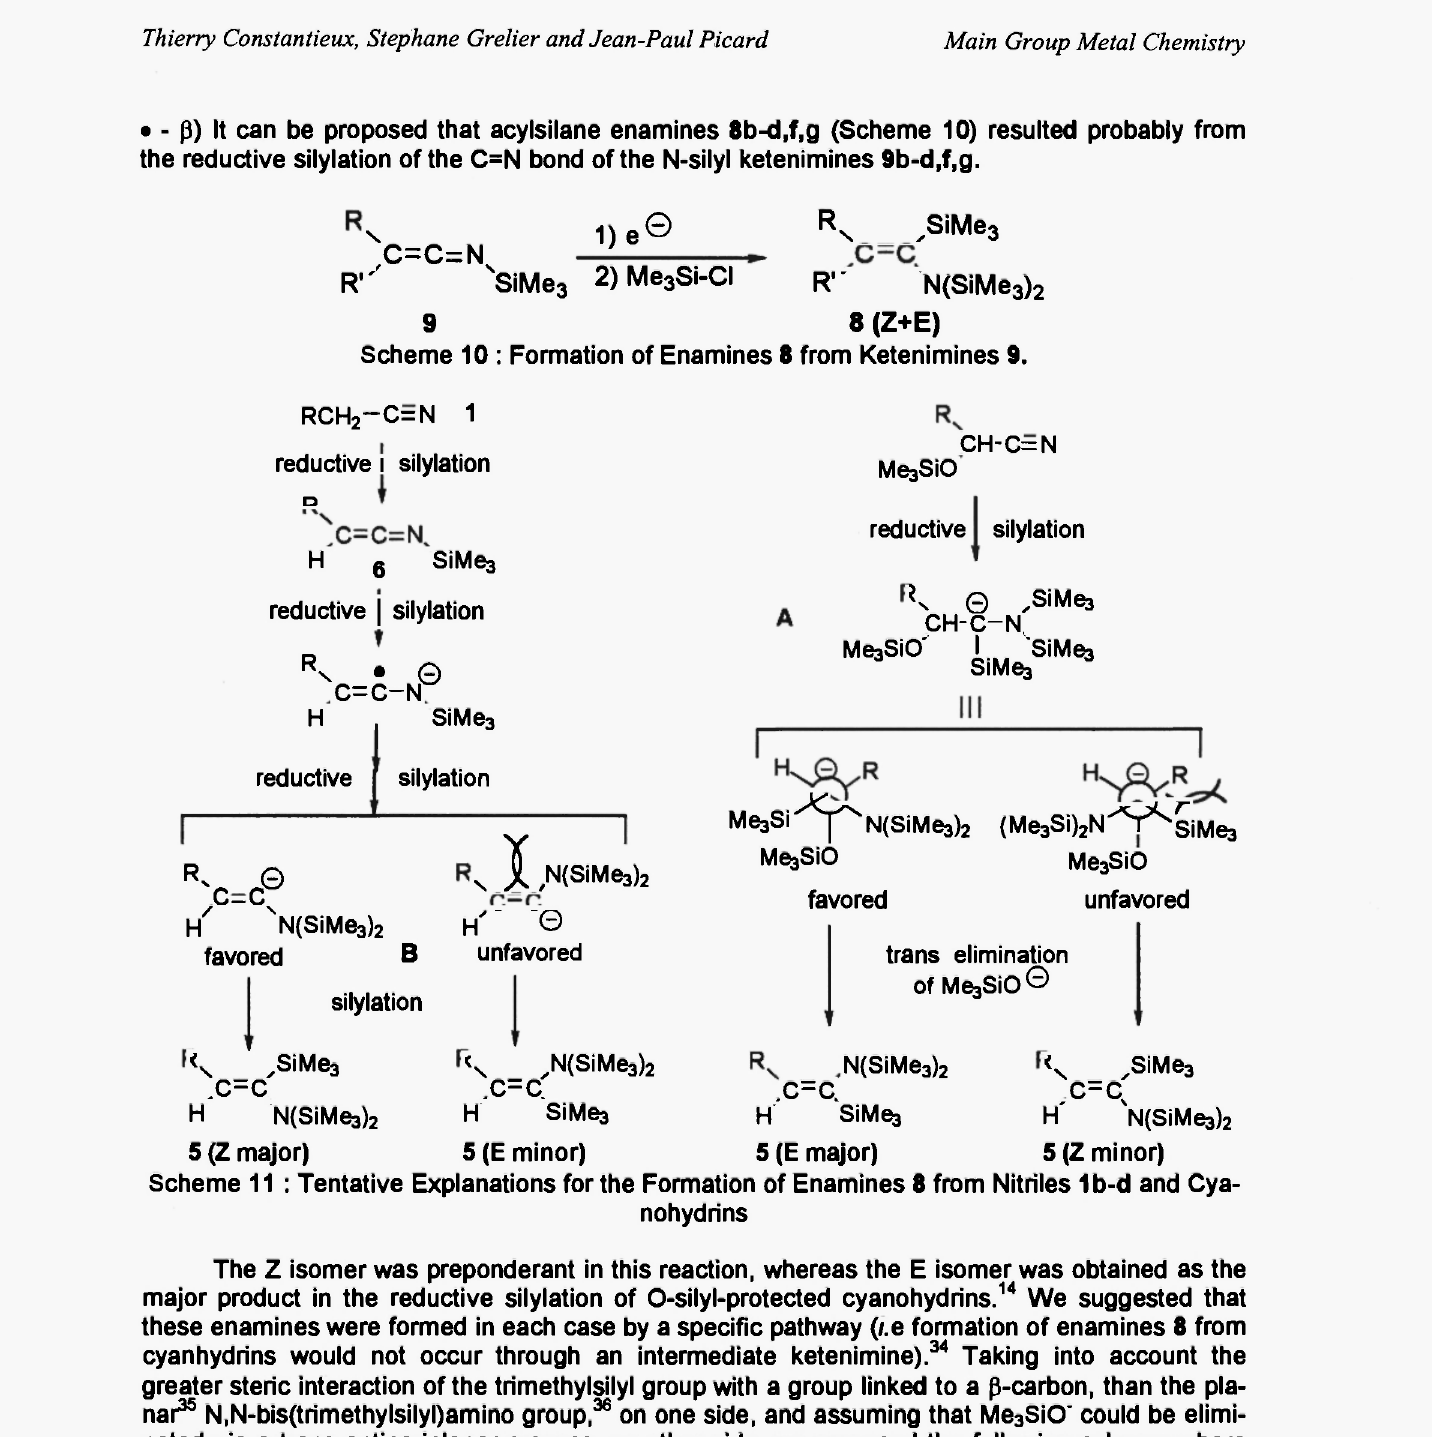
Scheme 11 : Tentative Explanations for the Formation of Enamines 8 from Nitriles Ib-d and